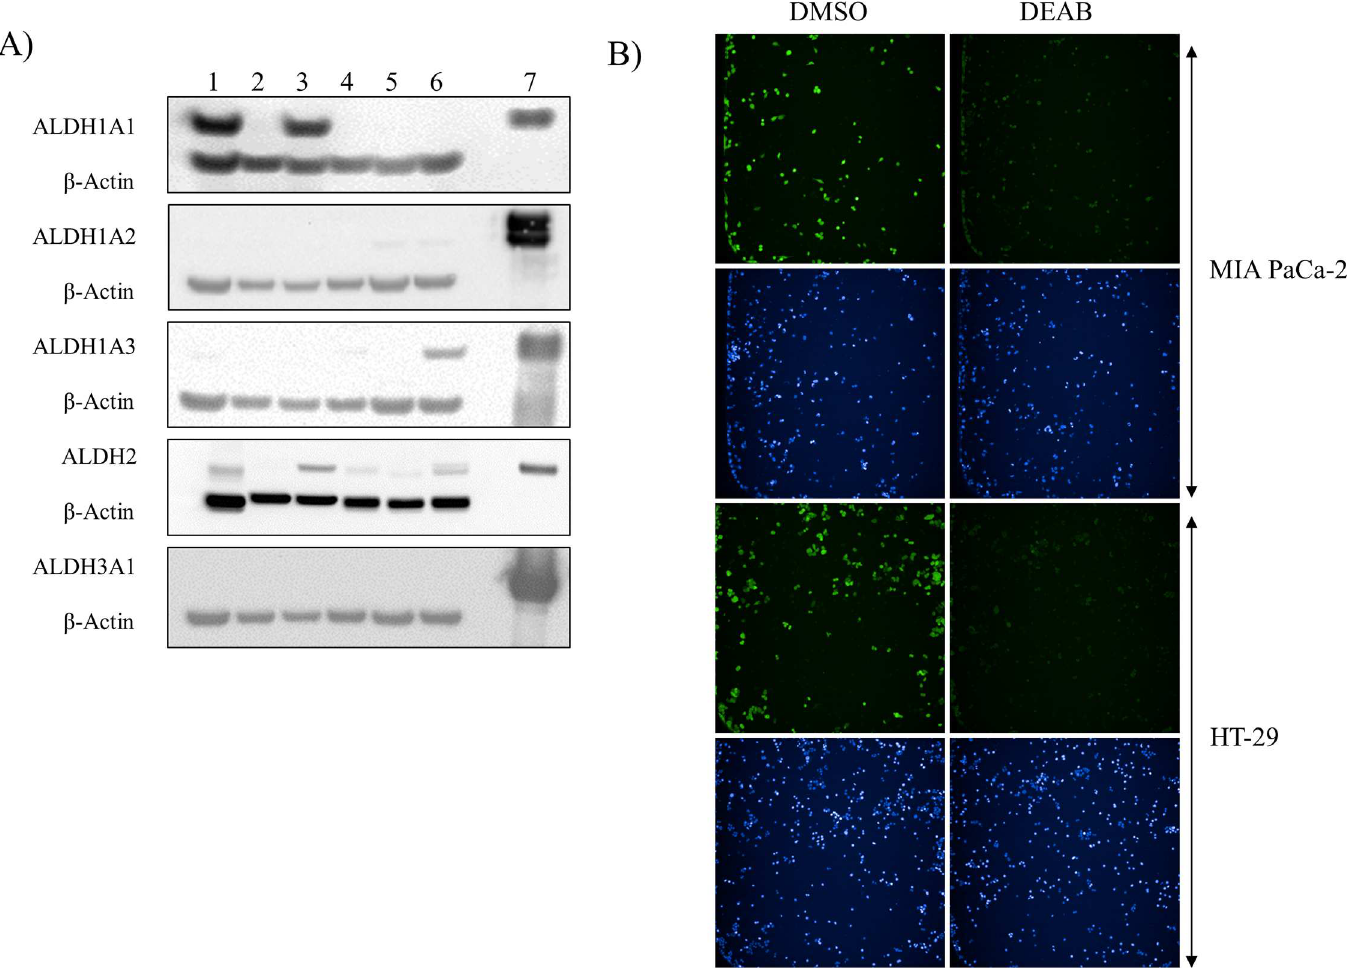
Fig 1. ALDH1A1 is differentially expressedin cancer cell lines and its activity can be indirectly visualized by BAA fluorescence. ( A ) Protein extracts from pancreatic cancer cell lines MIA PaCa-2 (lane 1) and PANC-1 (lane 2), colon cancer cell lines HT-29 (lane 3) and SW480 (lane 4) and gliomacell lines LN-18 (lane 5) and LN-229(lane 6) were analyzedby immunoblot for ALDH1A1, ALDH1A2,ALDH1A3,ALDH2 and ALDH3A1 expression. β -Actin was used as loadingcontrol. The corresponding recombinant protein was loadedfor reference (lane 7). ( B ) Representative fluorescent images of MIA PaCa-2and HT- 29 cells incubatedwith 500 nM of BAAA substrate and treated with 22 μ M DEAB or DMSO for 30 minutes. Green fluorescent images indicate intracellular BAA and blue fluorescent images indicate